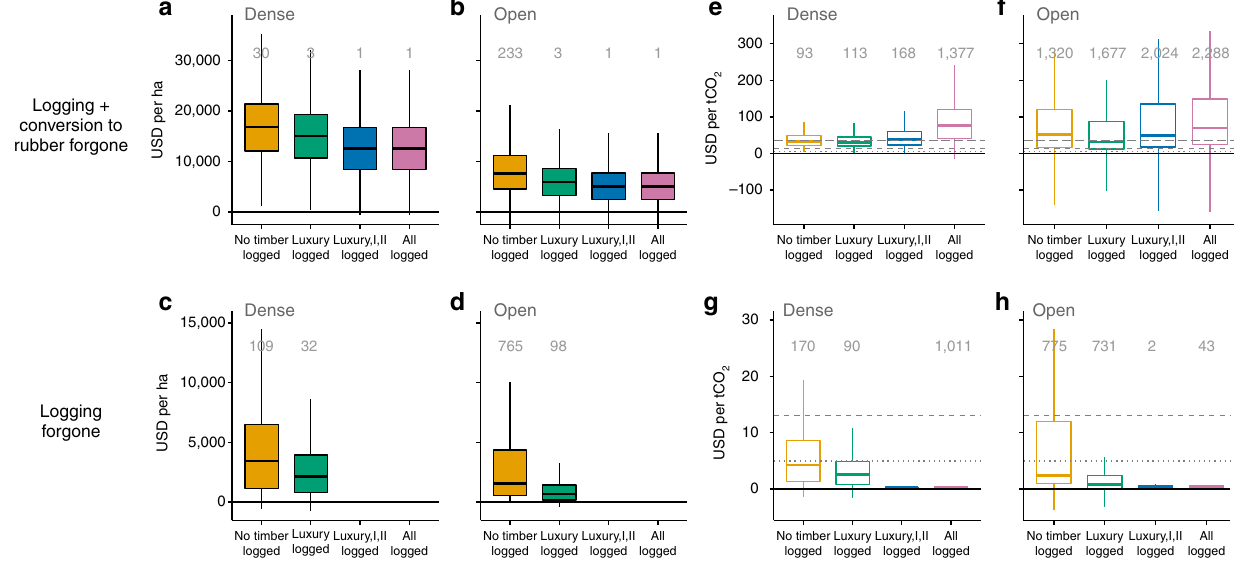
Fig. 3 Opportunity costs and breakeven carbon prices needed to protect forests from logging and conversion to rubber. Opportunity costs a – d include forgone pro fi ts from logging and rubber, or logging alone, offset by resin revenue except where resin trees (all class II) are logged out (in the “ Luxury, I, II logged ” and “ All trees logged ” scenarios). Breakeven carbon prices e – h are the prices needed to offset combined opportunity costs and carbon fi nance scheme setup (transaction) and implementation costs. Costs are shown separately for dense and open forests. Time-averaged post-deforestation land-use carbon stocks (taCs) partially offset forest carbon losses. Scenarios (of permitted selective logging, with and without potential for conversion to rubber) follow Fig. 1; boxplot format as Fig. 2. Grey lines on breakeven carbon price panels e – h represent indicative global carbon prices: dotted = $5 per tCO 2 (voluntary market forest carbon sales and non-market carbon fund prices), short dash = $13 per tCO 2 (compliance market prices) and long dash = $36 per tCO 2 (social cost of carbon, not shown on “ Logging forgone ” plots; see Supplementary Table 4). Outliers (>1.5× the interquartile range) are not displayed to improve the clarity of the fi gure; the value shown above each box-whisker gives the n outliers excluded out of 10,000 modelled